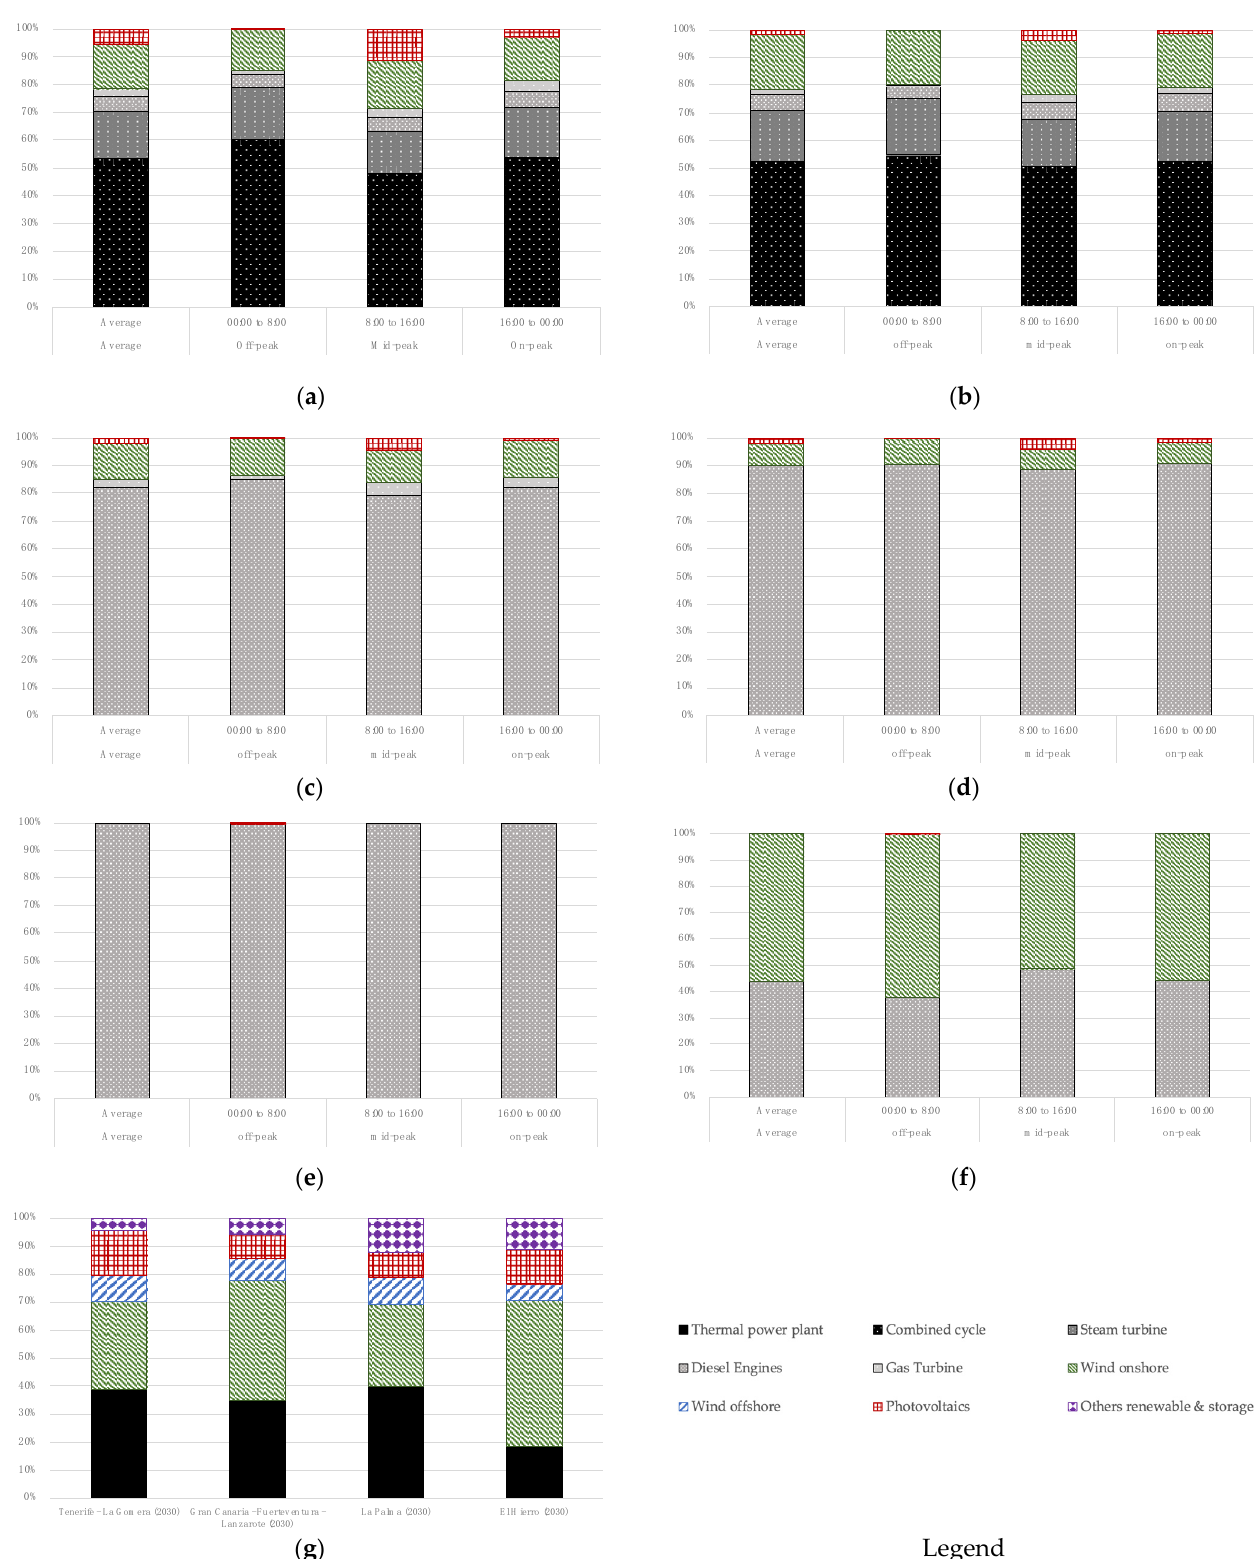
Figure 5. Electricity mixes by technology including hourly periods in 2021: ( a ) Tenerife 2021; ( b ) Gran Canaria 2021; ( c ) Fuerteventura-Lanzarote 2021; ( d ) La Palma 2021; ( e ) La Gomera 2021; ( f ) El Hierro 2021. ( g ) Average PTECan scenarios (2030) for the future systems.